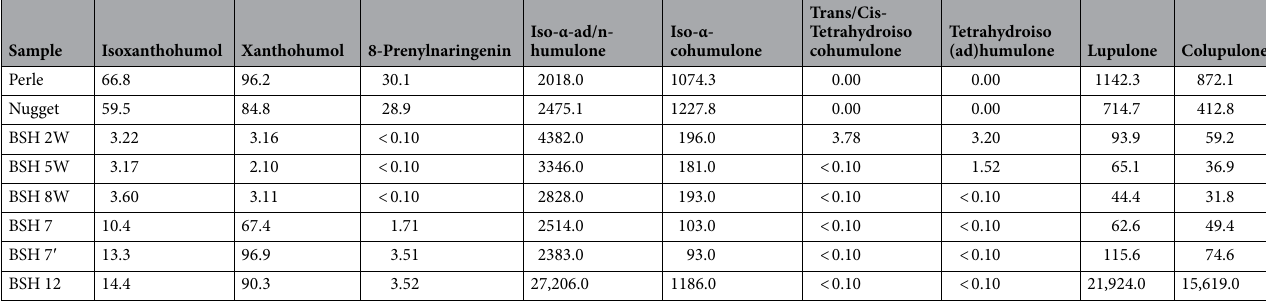
Table 2. LC-PDA-LTQ FT Orbitrap mass spectrometry analysis of hop and BSH extract samples. α and β-acids and prenylflavonoids concentration in mg/L.